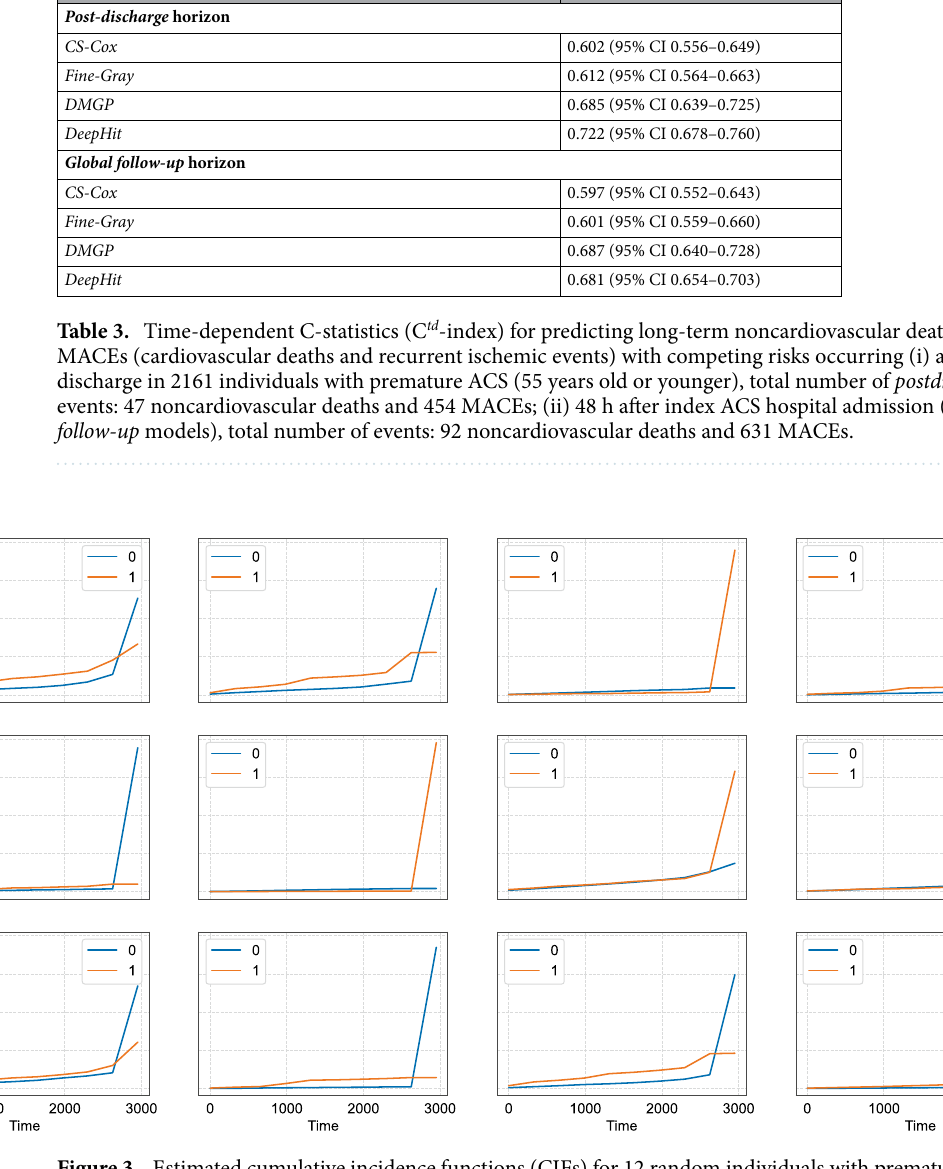
Figure 3. Estimated cumulative incidence functions (CIFs) for 12 random individuals with premature acute coronary syndrome (yACS) by using the DeepHit algorithm in the postdischarge horizon. Legend: zero (0) denotes CIF for noncardiovascular death, while one (1) means CIF for major cardiovascular adverse events (MACEs, cardiovascular deaths and recurrent ischemic events) occurring after discharge from index ACS